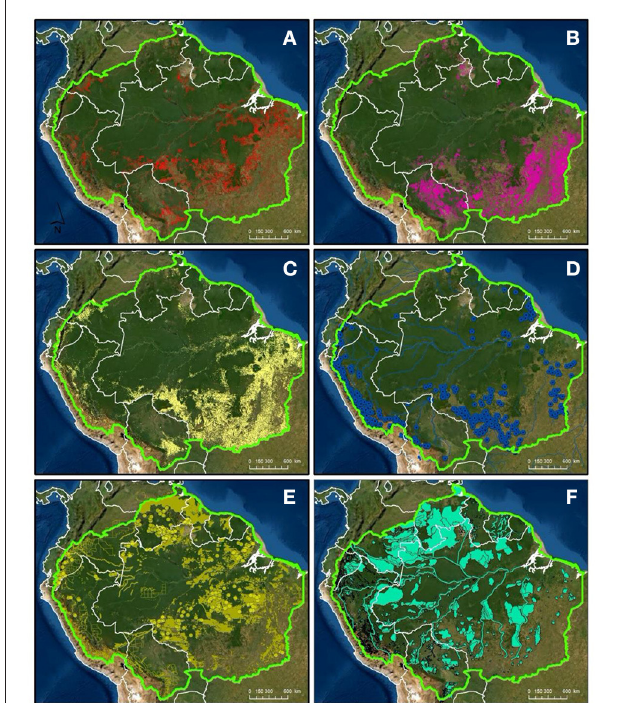
FIGURE 1 | Social and economic drivers of land use in the Amazon: (A) forest loss 2001–2019 (Hansen et al., 2013) (red shading), (B) fires 2001–2019 (RAISG, 2020) (pink shading), (C) agricultural and cattle areas (MAPBIOMAS Version 2.0, 2020) (yellow shading), (D) hydropower and reservoirs (RAISG, 2020) (blue points), (E) oil extraction and mining areas (RAISG, 2020) (yellow shading and points), and (F) fishing and hunting areas (RAISG, 2020) (aqua